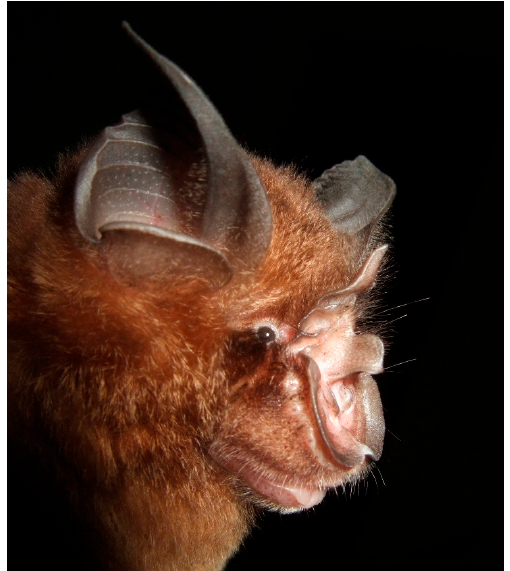
Figure 5. Rhinolophus affinis , adult male. Photograph by Vu Dinh Thong.